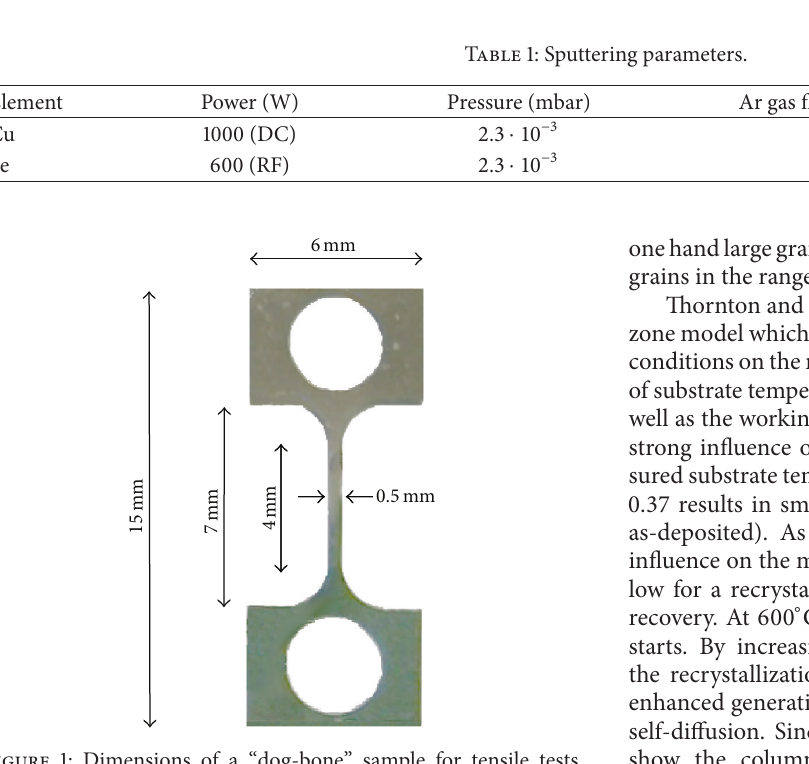
Figure 1: Dimensions of a “dog-bone” sample for tensile tests. The thickness of the different samples varied depending on batch between 28 𝜇 m and 32 𝜇